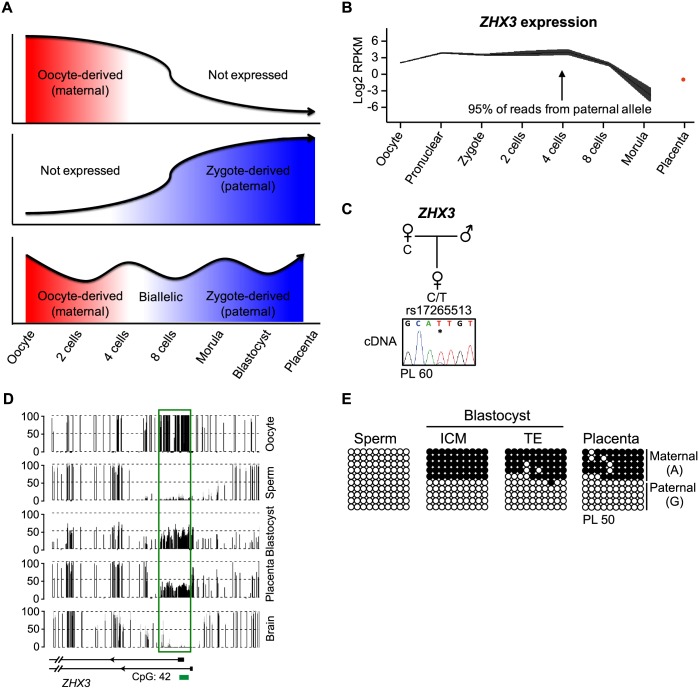
Identification of novel imprinted genes in human embryos using allele-specific RNA-seq datasets.(A) Schematic drawing of the sequential transcriptome switching from oocyte-derived transcripts to the embryonic genome in human preimplantation embryos. (B) The expression pattern of the ZHX3 gene during human preimplantation development. High expression was observed from the zygote to the 8-cell stage, declining in the morula. Paternal expression as observed from the 4-cell stage onwards. (C) Allele-specific RT-PCR was performed on term placenta samples heterozygous for the exonic SNP rs17265513. (D) Methyl-seq traces reveal the location of the placenta-specific maternal gDMR overlapping the ZHX3 promoter. The vertical black lines in the methyl-seq tracks represent the mean methylation value for individual CpG dinucleotides. The green box highlights the position of the gDMRs. (E) The methylation profile confirmed using bisulphite PCR and cloning in sperm, blastocysts and placenta. Each circle represents a single CpG dinucleotide on a DNA strand. (•) Methylated cytosine, (o) unmethylated cytosine. Each row corresponds to an individual cloned sequence. For clarity only the first 10 CpG dinucleotides are shown.